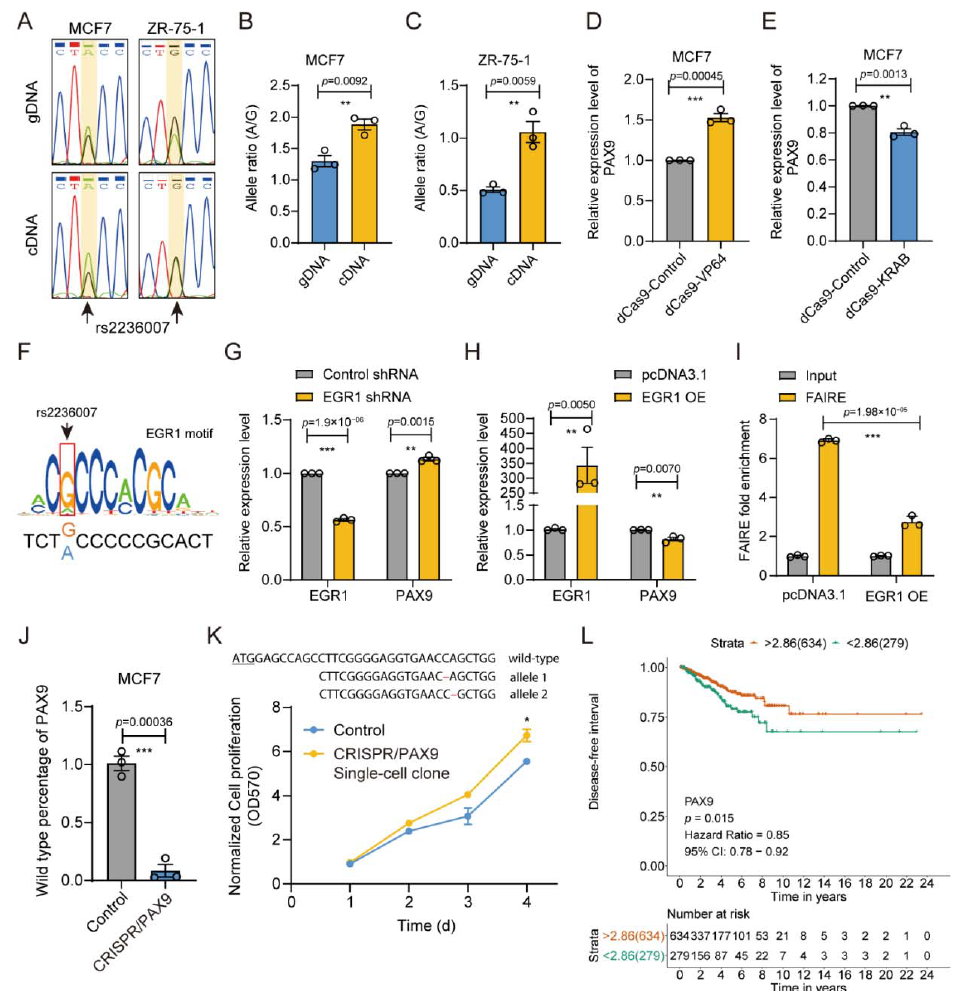
Figure 8. The rs2236007 variation alters PAX9 expression. ( A ) Sanger sequencing chromatography of the rs2236007 region for genomic DNA and cDNA of MCF7 and ZR ‐ 75 ‐ 1 cells. The position of rs2236007 is highlighted in a yellow square. Representative images from triplicate experiments. ( B , C ) Allele preference analysis of rs2236007 site in genomic DNA and cDNA determined by AS ‐ qPCR in MCF7 ( B ) and ZR ‐ 75 ‐ 1 ( C ) cells. Mean ± SD of three technical replicates. ** p < 0.01, two ‐ tailed Student’s t ‐ test. ( D ) CRISPR ‐ mediated activation of the PAX9 gene using dCas9 ‐ VP64 guided to the rs2236007 region in MCF7 cells determined by RT ‐ qPCR. Mean ± SD of three independent experiments. *** p < 0.001, two ‐ tailed Student’s t ‐ test. ( E ) CRISPR interference of the PAX9 gene using dCas9 ‐ KRAB guided to the rs2236007 region in MCF7 cells determined by RT ‐ qPCR. Mean ± SD of three independent experiments. ** p < 0.01, two ‐ tailed Student’s t ‐ test. ( F ) PWM motif prediction in the JASPAR database showing the G allele ‐ preferred binding of EGR1 to the rs2236007 region. ( G ) The effect of ERG1 shRNA knockdown on the gene expression of PAX9 in MCF7 cells was determined by RT ‐ qPCR. Mean ± SD of three independent experiments. ** p < 0.01, *** p < 0.001, two ‐ tailed Student’s t ‐ test. ( H ) The effect of EGR1 overexpressed on PAX9 expression in MCF7 cells was determined by RT ‐ qPCR. Mean ± SD of three technical replicates. ** p < 0.01, two ‐ tailed Student’s t ‐ test. ( I ) FAIRE ‐ qPCR analysis showing the impact of EGR1 overexpression on the openness of the rs2236007 region in MCF7 cells. Mean ± SD of three technical replicates. *** p < 0.001, two ‐ tailed Student’s t ‐ test. ( J ) Evaluation of genome editing frequency on the PAX9 gene in MCF7 cells determined with getPCR analysis. Mean ± SD of three technical replicates. *** p < 0.001, two ‐ tailed Student’s t ‐ test. ( K ) Cell proliferation assay of MCF7 single ‐ cell clone with PAX9 knocked out through CRISPR/Cas9. OD570 was acquired using the PrestoBlue ® Cell Viability Reagent. The genotype of the clone (top) indicating one ‐ base deletion variations on both alleles. Start codon ATG is highlighted with an underline. Mean ± SD of three biological replicates. * p < 0.05, two ‐ tailed Student’s t ‐ test. ( L ) Kaplan–Meier survival analysis showing the disease ‐ free interval of breast cancer patients from the TCGA cohort, stratified according to the expression level of PAX9 (strata point = 2.68). The HR was provided with a 95% confidence interval, and p values were calculated with the log ‐ rank test.